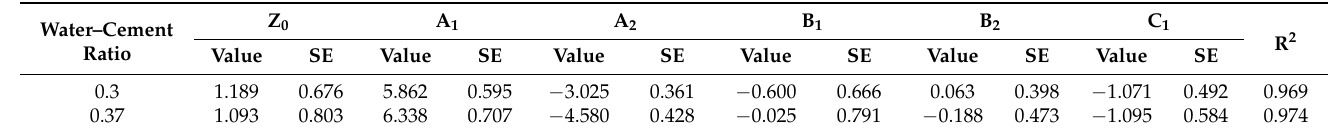
Table 5. Prediction equation fitting of 28-day concrete in flexural strength.